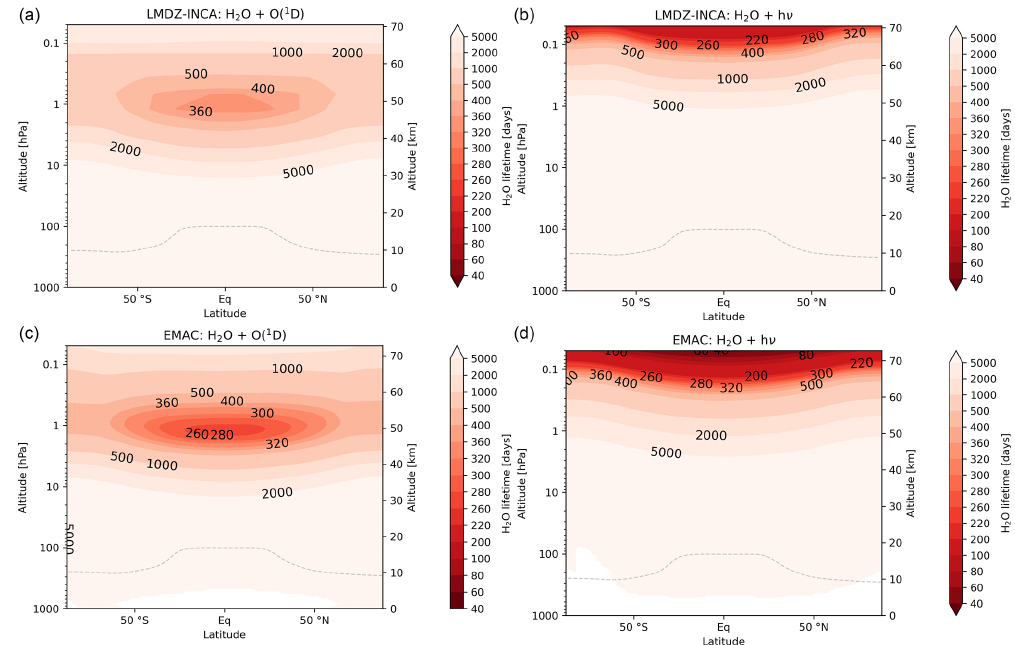
Figure A5. Zonal mean (photo-)chemical H 2 O lifetime in days for photolysis (b, d) and reaction with O( 1 D) (a, c) for LMDZ-INCA (a, b) and EMAC (c, d) .